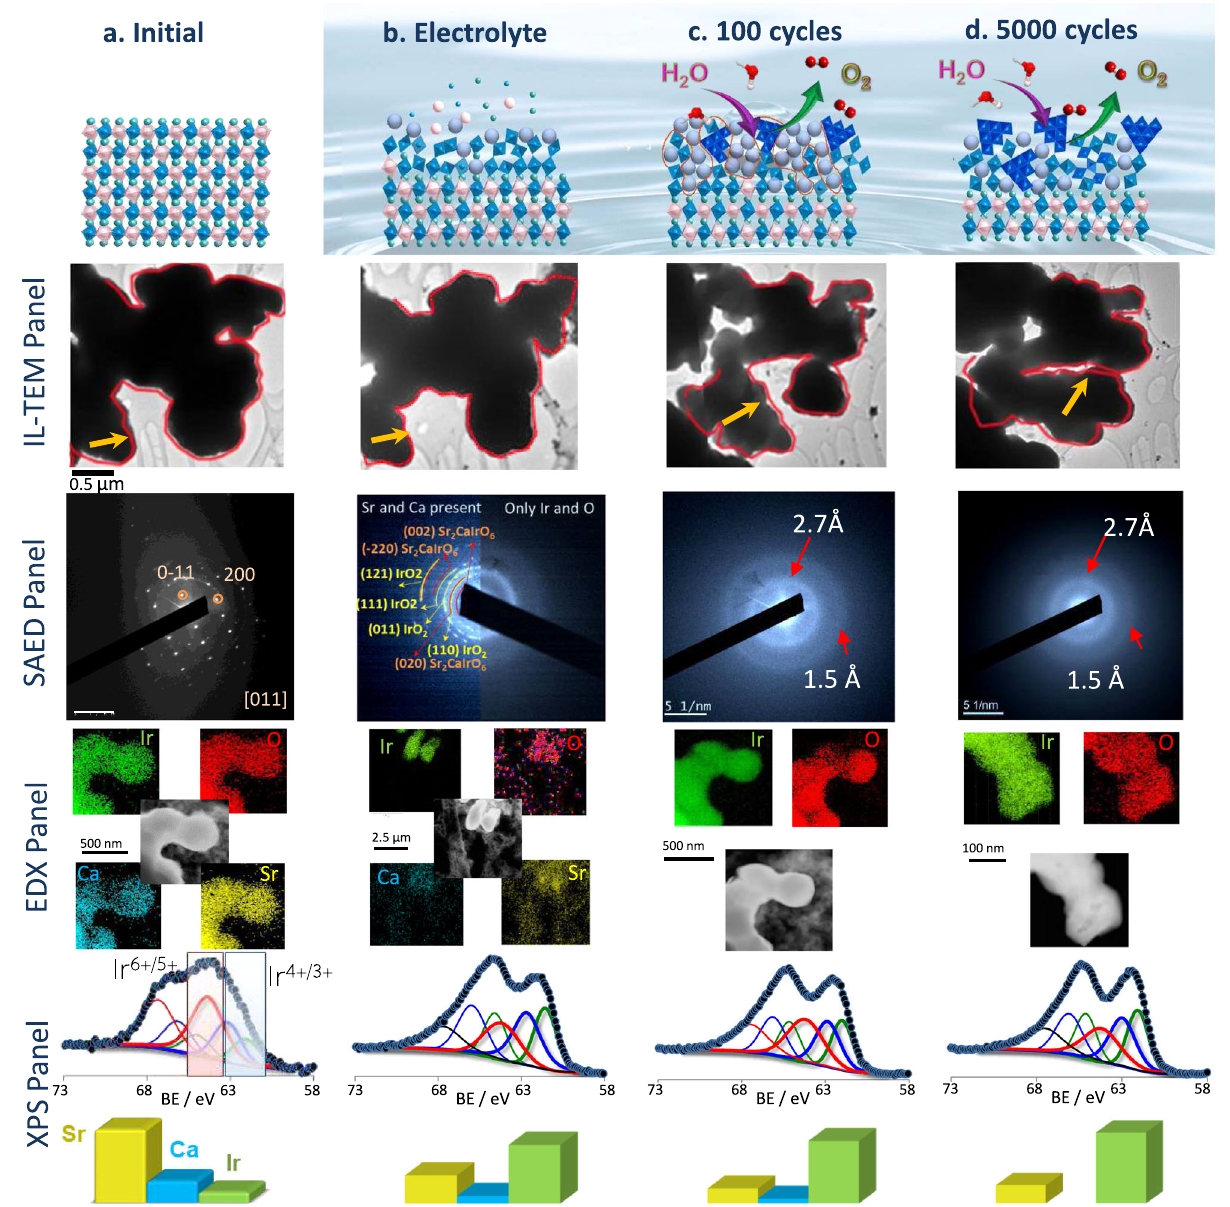
Fig. 2 | Evolution of Sr 2 CaIrO 6 in the electrolyte and during the OER. a Fresh Sr